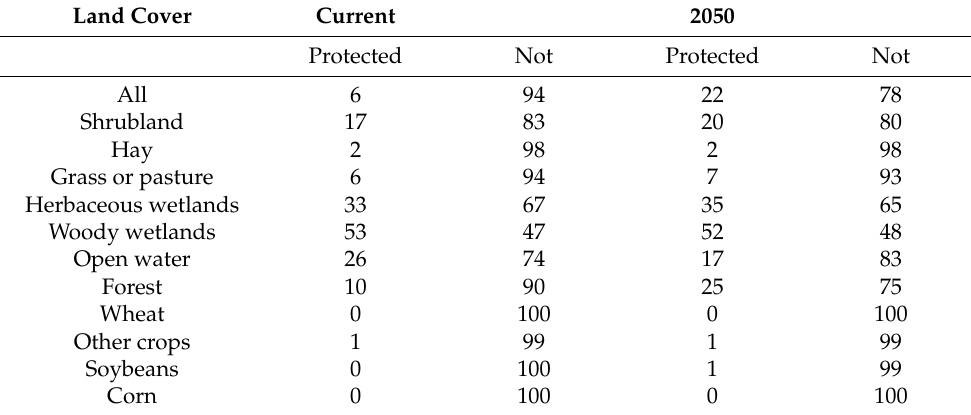
Table 1. Percentages of land cover classes with protected status (or not protected) in areas where suitability > 0.5 either currently or in